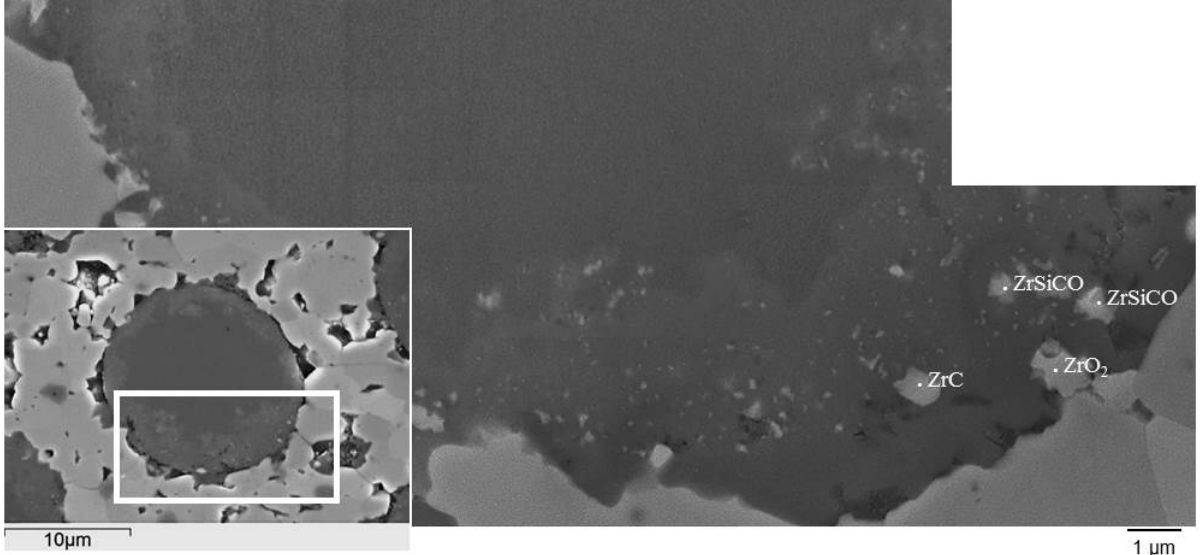
Figure 6. Multilayered core-shell morphology of a SiC fiber in a ZrB